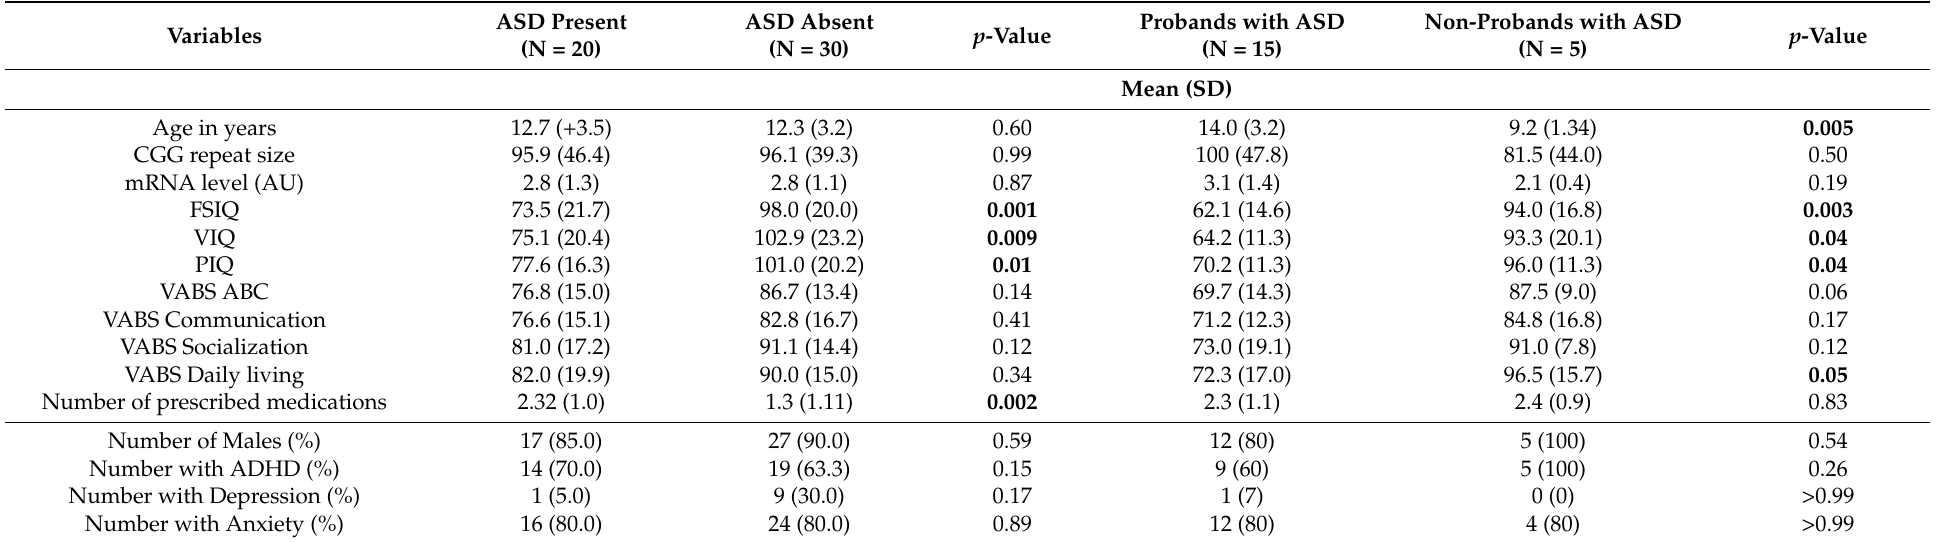
Table 3. Presence of ASD in young PM carriers and its associated